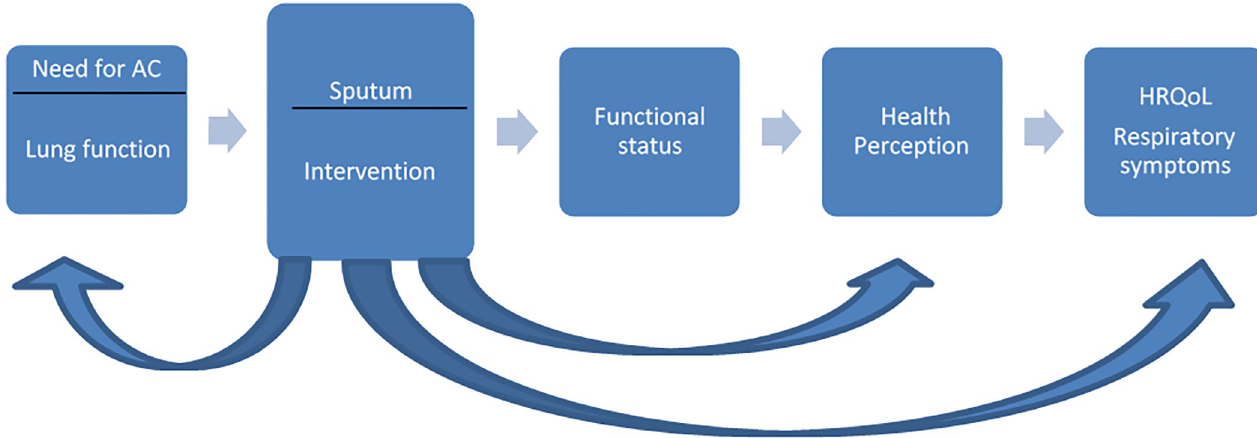
Fig 5. Need for airway clearance, study intervention and the relationships with HRQoL and lung function. https://doi.org/10.1371/journal.pone.0276310.g005 PLOS ONE | https://doi.org/10.1371/journal.pone.0276310 October 18,